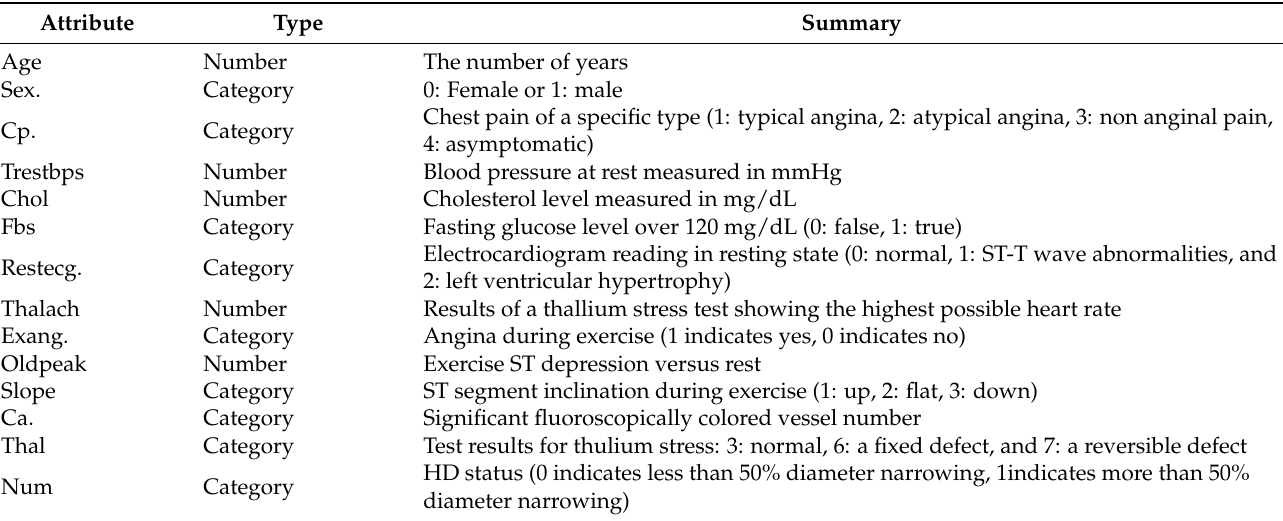
Table 1. Attributes description of Cleveland and Statlog datasets